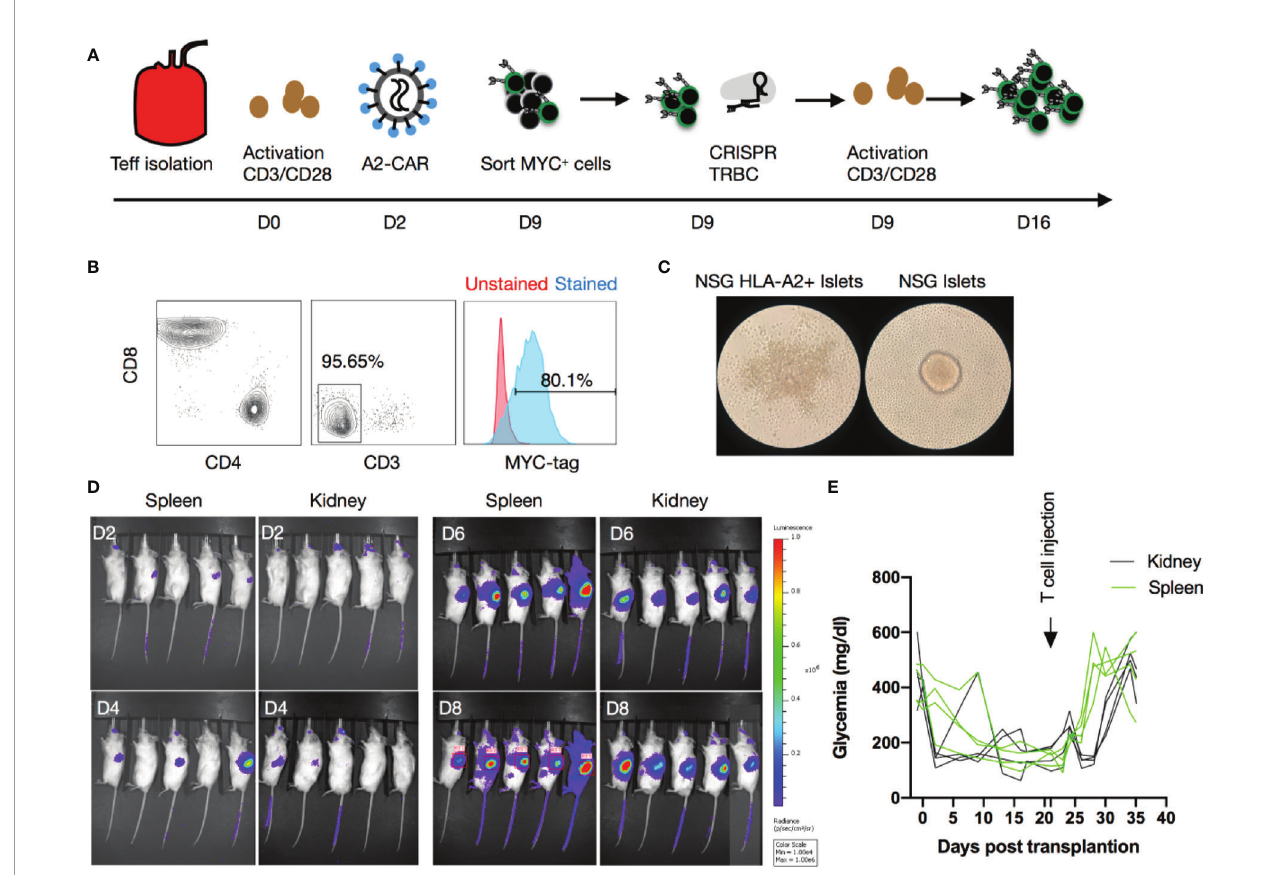
FIGURE 2 | Human A2-CAR T cell traf fi cking and function in an islet transplantation model. (A) Experimental design of human T-cell engineering and expansion. (B) Editing ef fi ciency as measured by CD3 and MYC-tag expression on T cells prior to infusion from an HLA-A2 negative donor after CRISPR editing of the TCR ( TRBC ) and transduced with a lentivirus consisting of a A2-CAR linked to a luciferase reporter gene by a 2A self-cleaving peptide. (C) WT NSG or HLA-A2 transgenic NSG mouse islets pictured 48h after co-culture with A2-CAR T cells (100 IEQ with 1 x 10 5 T cells). Result shown is representative of two experiments using Tregs from 3 unrelated donors. (D) Luciferase activity over time after infusion of 2 x 10 6 A2-CAR T cells in mice that received an A2 transgenic murine islet transplant either under the left kidney capsule or into the spleen. (E) Glycemia monitoring after streptozotocin (STZ) injection, islet transplantation, and T-cell infusion (2 x 10 6 /mouse from a HLA-A2 negative donor). An insulin pellet was placed subcutaneously in mice with partial graft function (blood glucose >200mg/dl) on Day 10 after